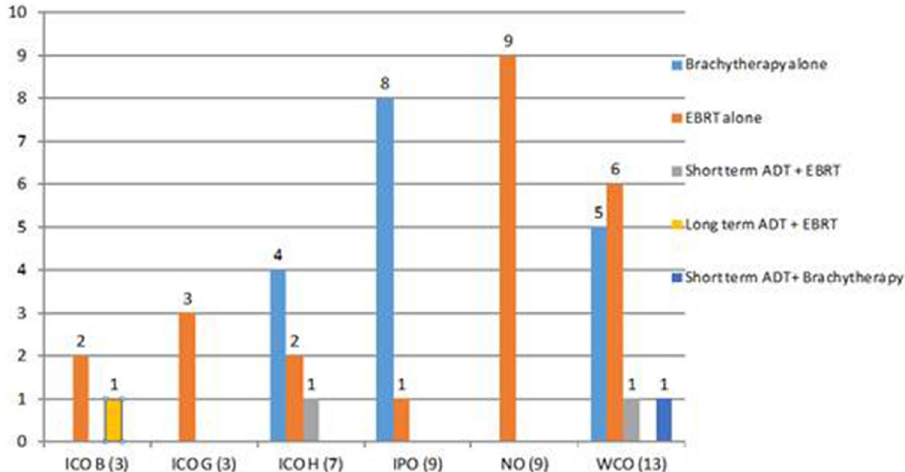
Figure 1. Treatment administered in low-risk patients and number of patients per treatment type.